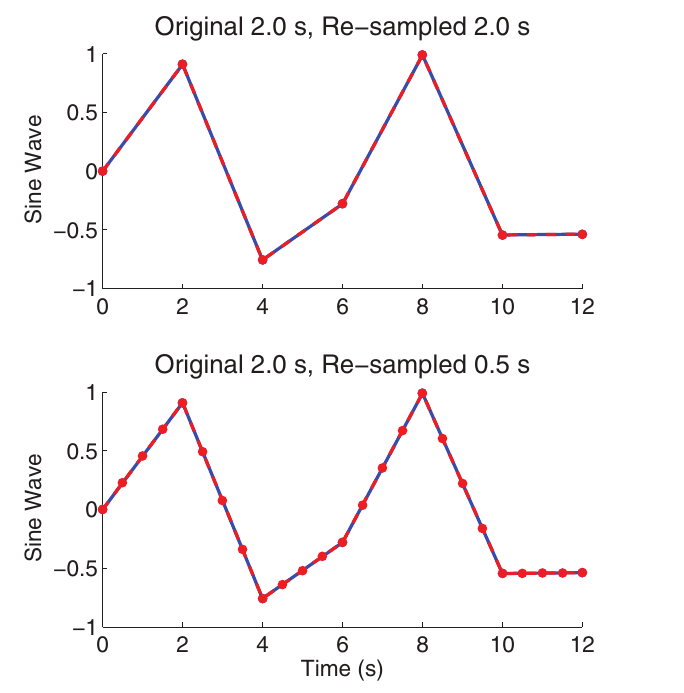
re-sampling errors—the minimum and maximum values for the red curve are closer to zero than for the blue curve. Linear re-sampling from 2.0 or 2.5s into 0.5s ( lower-left and lower-right panels) does not introduce such re-sampling errors, though of course it cannot recover sine wave values for time points falling in-between the originally-sampled time points.